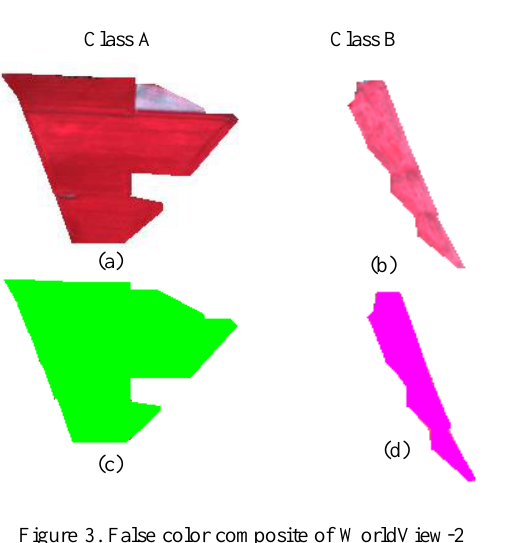
Figure 4. Certainty of pixels in spectral domain to class A ((a) and (b)) and class B ((c) and (d)). Values ranges from uncertainty (0, black) to certain (1, white)